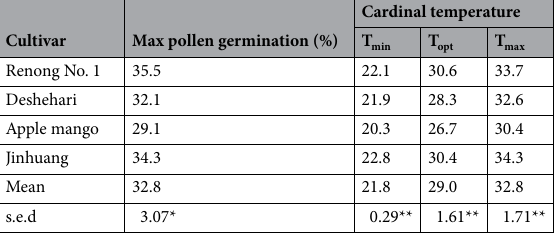
Table 1. Maximum pollen germination percentage and cardinal temperatures for pollen germination of four mango genotypes in response to different temperature stress. *P < 0.05, **P < 0.01.